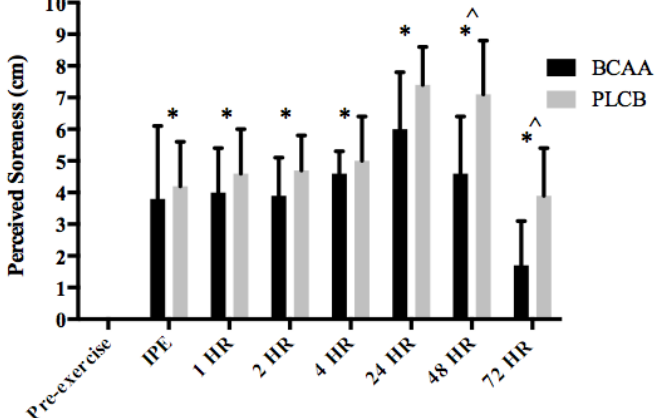
Figure 5. Mean (± standard deviation) perceived soreness rating (cm; centimeters) pre-eccentric exercise, immediate post (IPE), 1, 2, 4, 24, 48 and 72 hours (HR) for resistance trained men supplementing with branched-chain amino acids (BCAA) or placebo (PLCB) ( n = 20). * = significantly different from pre-exercise for both BCAA and PLCB ( p < 0.05); ^ = significantly different from PLCB group ( p < 0.05).